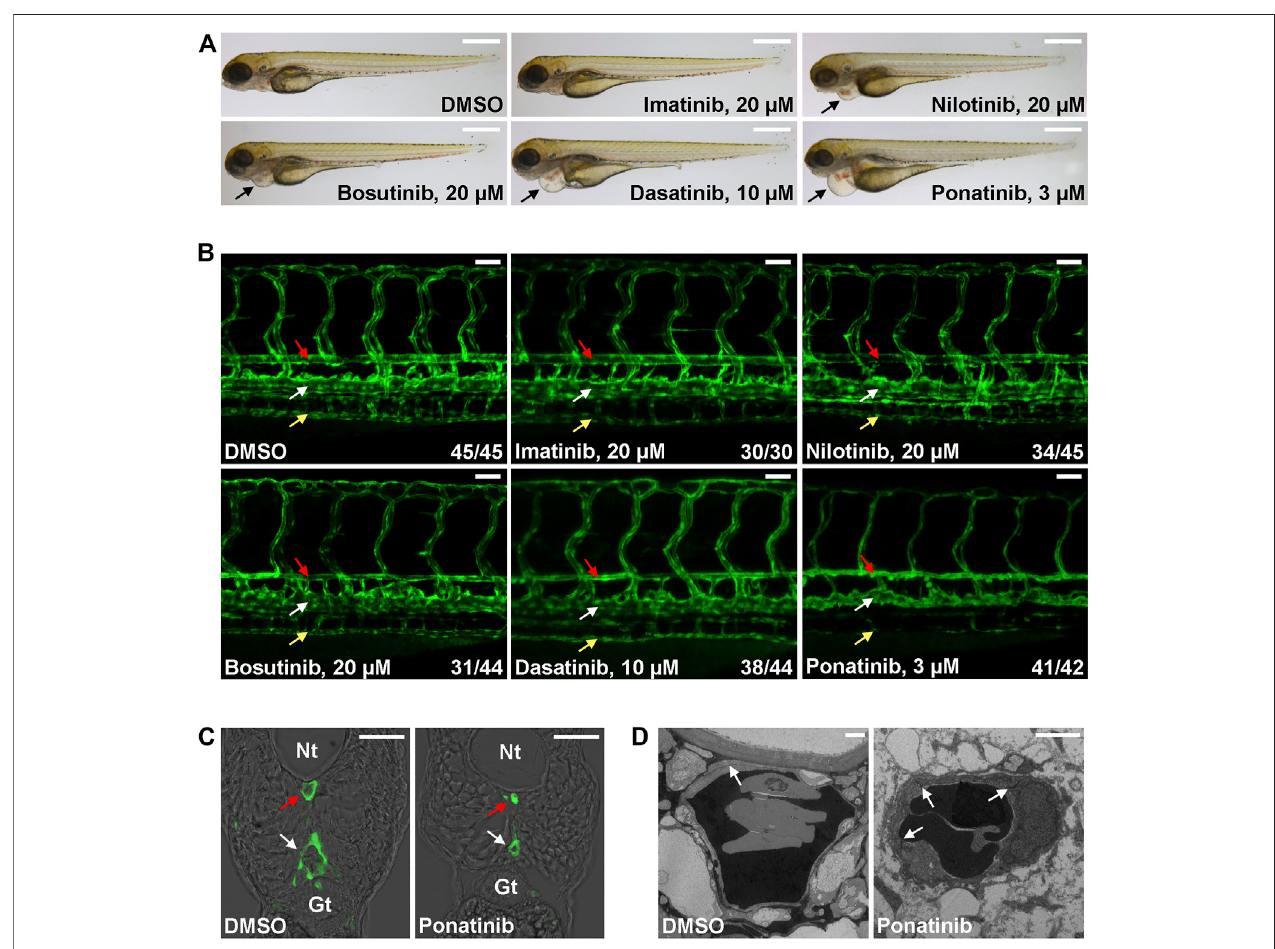
FIGURE1| CardiovasculardefectsinCMLTKItreatedzebra fi shembryos. (A) LiveimagingofembryostreatedwiththeindicatedconcentrationsofTKIsfrom2to4 dpf.Arrowsindicatecardiacedema.Scalebar:500 µm. (B) ConfocalimagingofvesseldefectsinTKItreated Tg( fl k:GFP) embryos.Redarrow:dorsalaorta;whitearrow: posterior cardinal vein; yellow arrow: subintestinal vein. At least two biological repeats were performed. Numbers indicate (number of embryos with shown phenotype/ total number of embryos analyzed). Scale bar: 50 µm. (C) Cross-section of ponatinib-treated embryos. Nt: neural tube; Gt: gut; red arrow: dorsal aorta; white arrow: posterior cardinal vein. Scale bar: 50 µm. (D) TEM analysis of ponatinib-treated embryos. White arrow: aortic endothelial cell junctions. Scale bar: 2